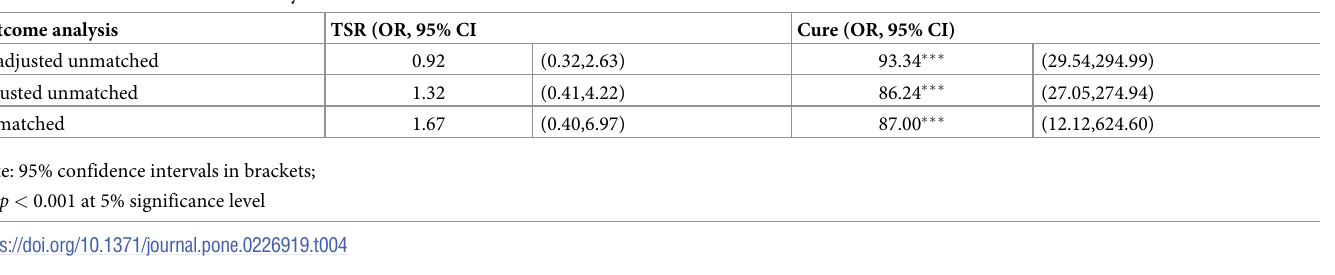
Table 4. Matched and unmatched analysis for effect of SSM on